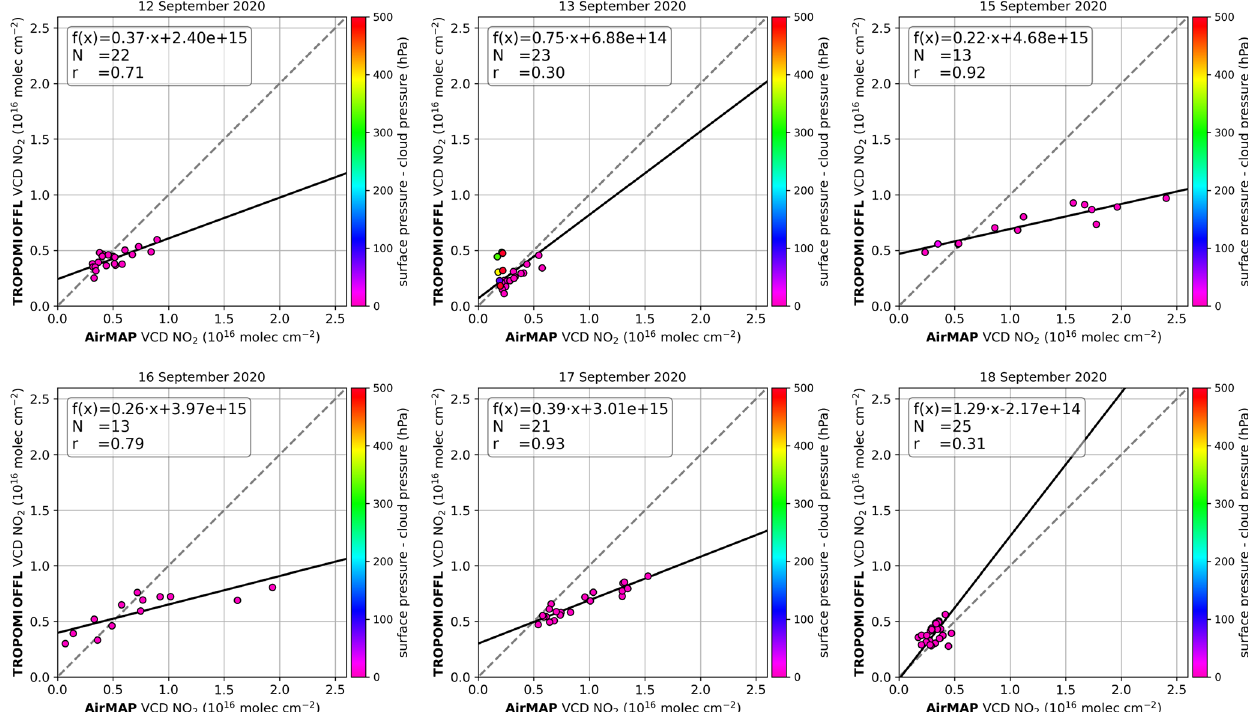
Figure A8. Daily scatter plots of TROPOMI operational OFFL V01.03.02 tropospheric NO 2 VCDs vs. co-located AirMAP tropospheric NO 2 VCDs for the 6 measurement days. Points are color coded to show the surface and cloud pressure difference. AirMAP measurements are considered as co-located and gridded to the TROPOMI pixel if they are taken ± 30min around the S5P overpass and are covering at least 75% of the TROPOMI